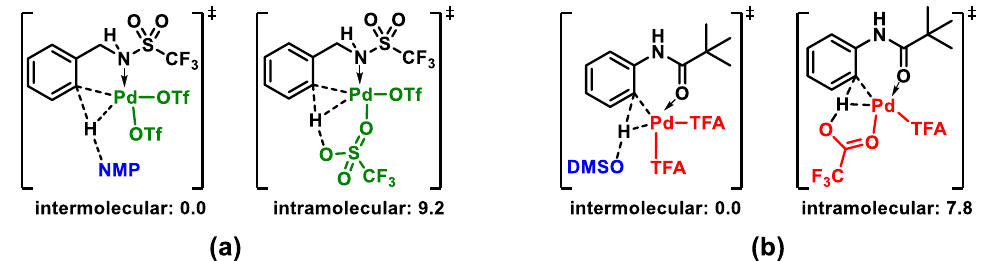
Figure 4. Calculated relative activation free energies (kcal/mol) of intermolecular and intramoleculular CMD mechanism. Intermolecular models were chosen as the reference point. ( a ) NMP−assistant process; ( b ) DMSO−assistant process.